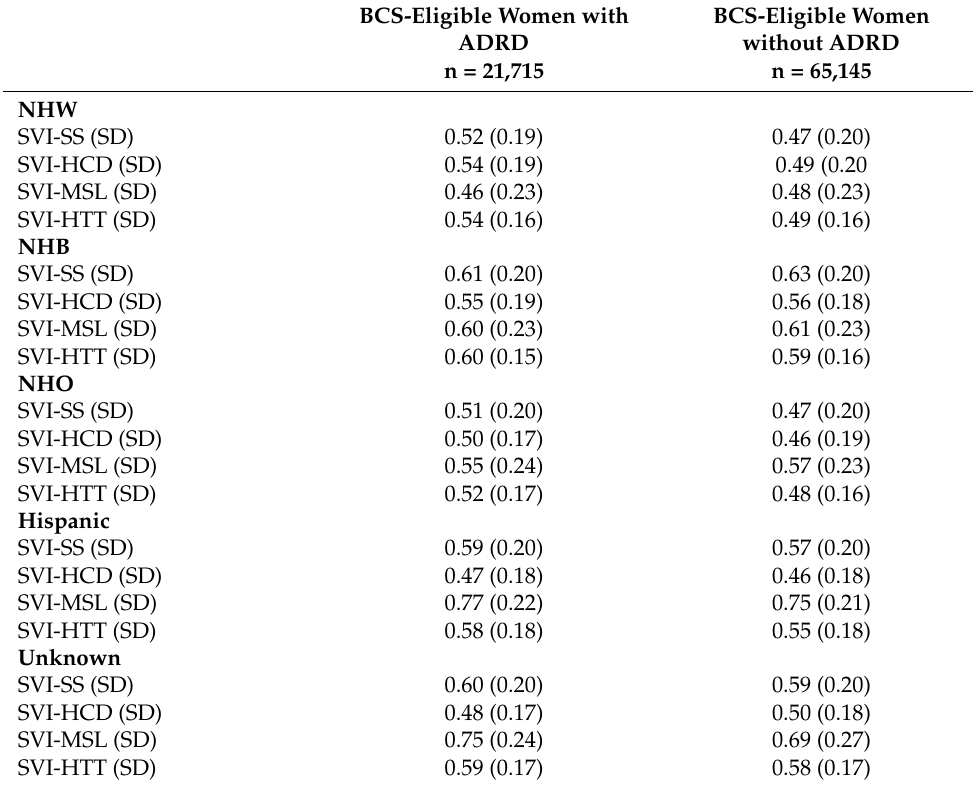
Table 2. Social vulnerability of the study population by race.